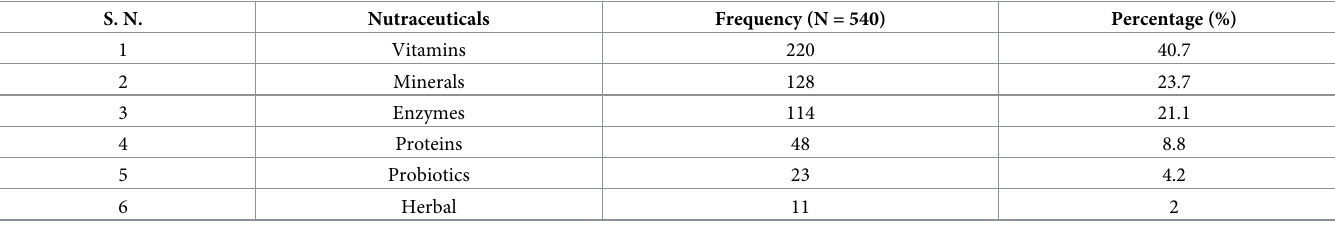
Table 2. Percentage of nutraceuticals